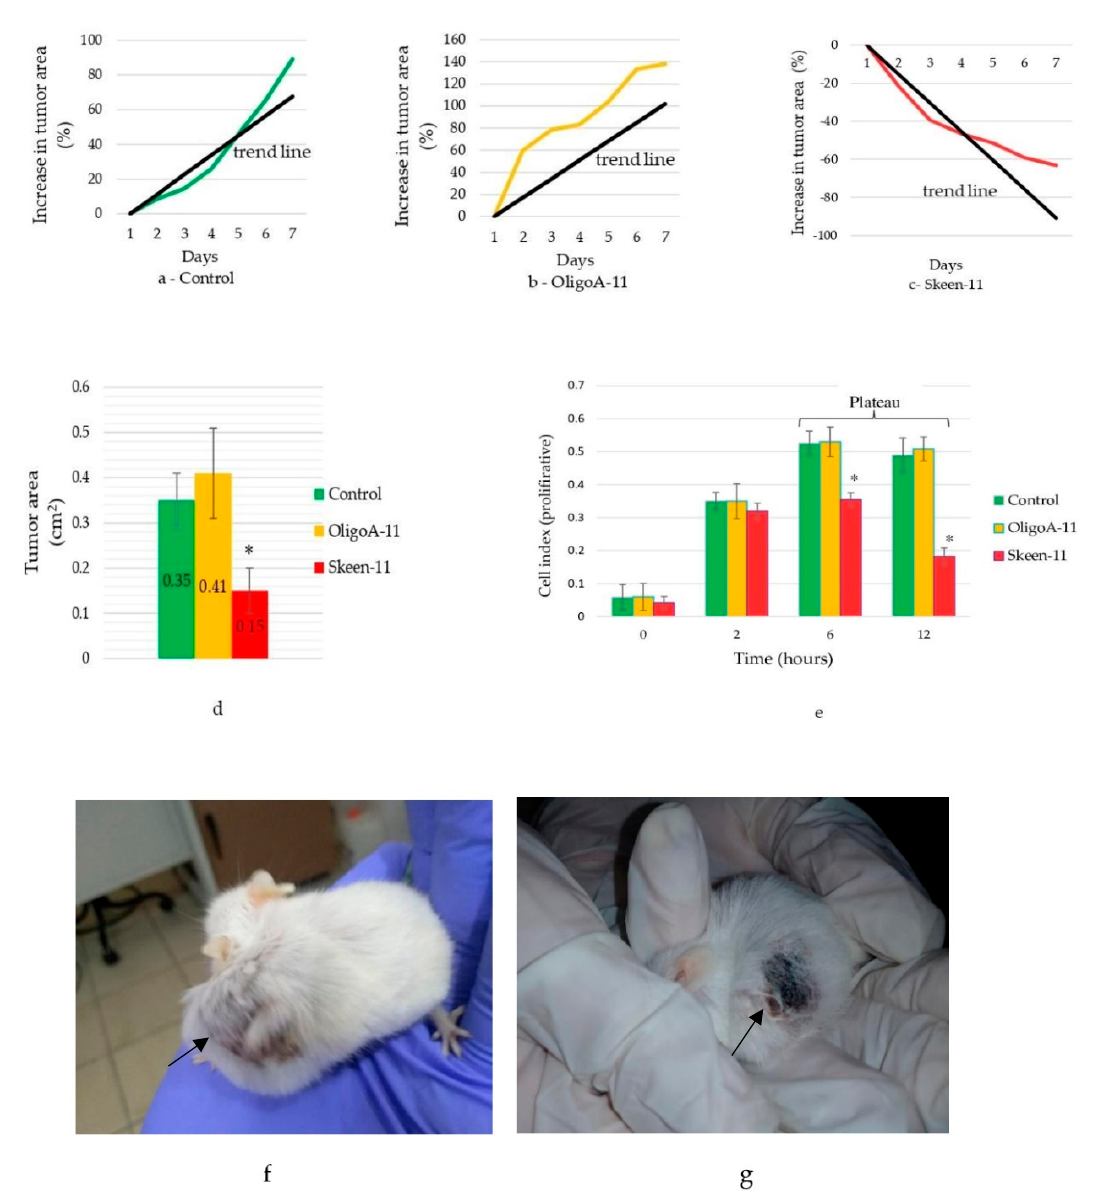
Figure 1. Dynamics of the average cumulative increase in tumor area for the different experimental groups on the 7th day of the experiment: ( a )—control; ( b )—OligoA-11; ( c )—Skeen-11; ( d )—average tumor area; ( e )—dynamics of the cell index (proliferation) in different experimental groups; ( f )—tumor formed on the 18th day after inoculation; ( g )—tumor reduction on the 7th day after Skeen-11 treatment at a concentration of 30,000 ng/µL (21st day from the start of the experiment) (indicated by arrow); values are shown with the means and SE. A significant difference compared to the control group ( p < 0.05) is marked with *.